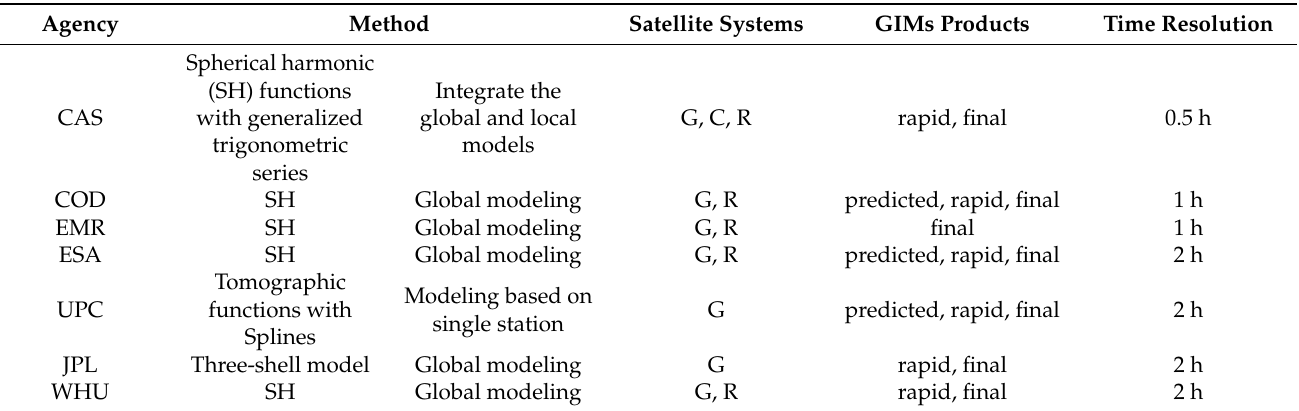
Table 1. Processing strategy and products information of GIMs from each analysis